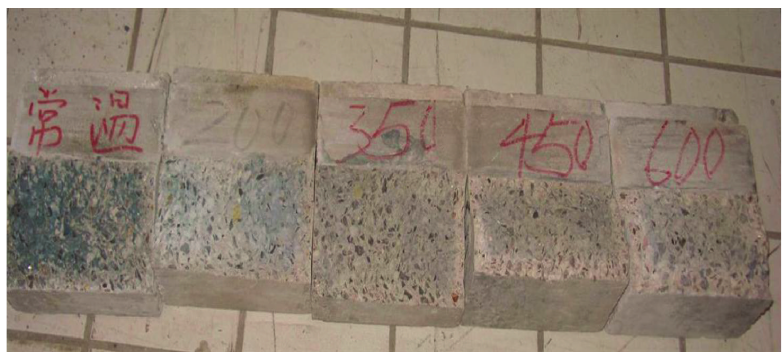
Figure 5: Fracture surfaces of postfire